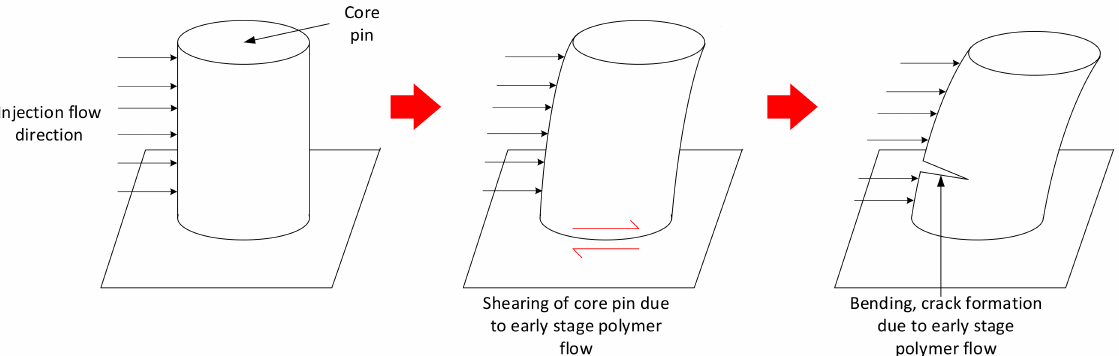
Figure 1. Graphical representation of hypothesized load case. This shows bending and shear of core pin due to incoming polymer flow during the injection